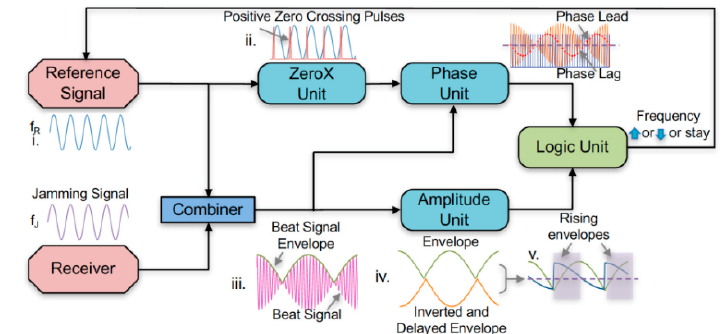
Figure 14. Illustration of the JAR design for adaptive frequency-hopping system. The four functional units are ZeroX unit, Phase unit, Amplitude unit, and Logic unit.